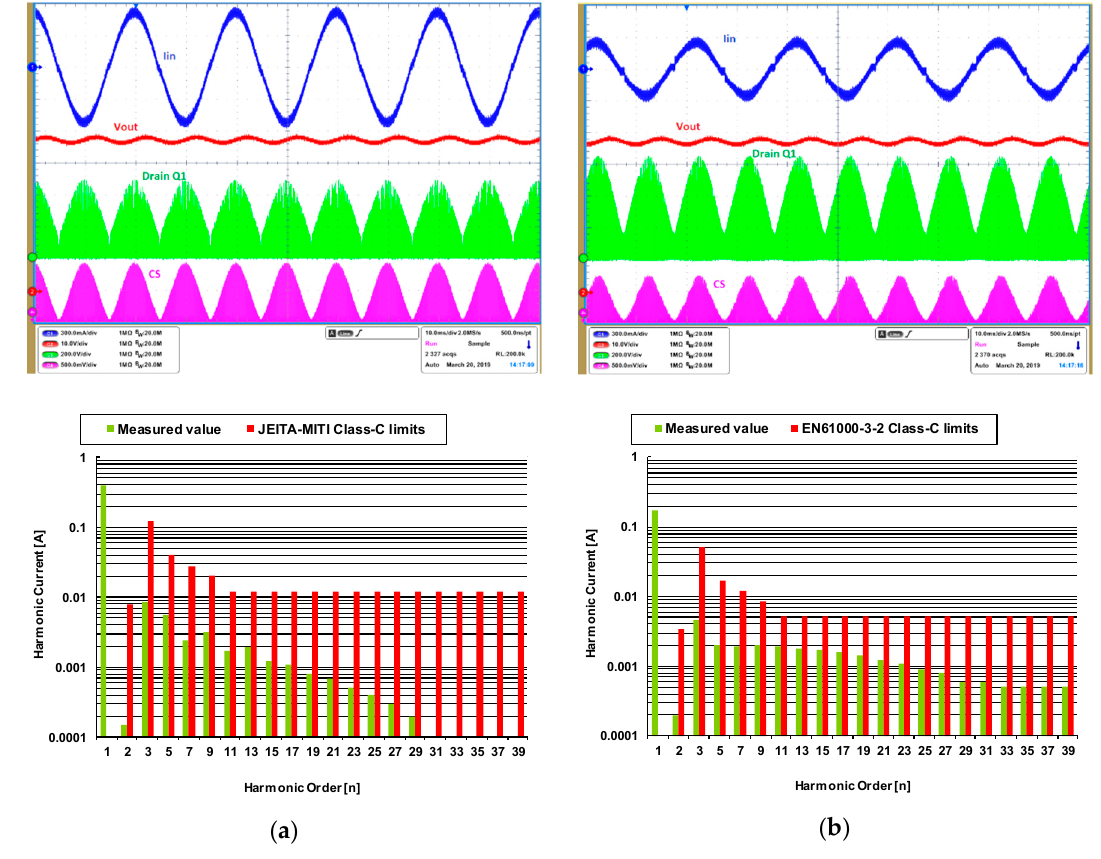
Figure 11. Steady-state waveforms at full-load: ( a ) V in = 110 V at 60 Hz. ( b ) V in = 230 V at 50 Hz. They have been overlapped by the harmonic contributions of the input current (green bars) with the Japanese norm JEITA_MITI Class-C ( a ), and European norm EN61000-3-2 Class-C ( b ) (red bars) for lighting equipment.